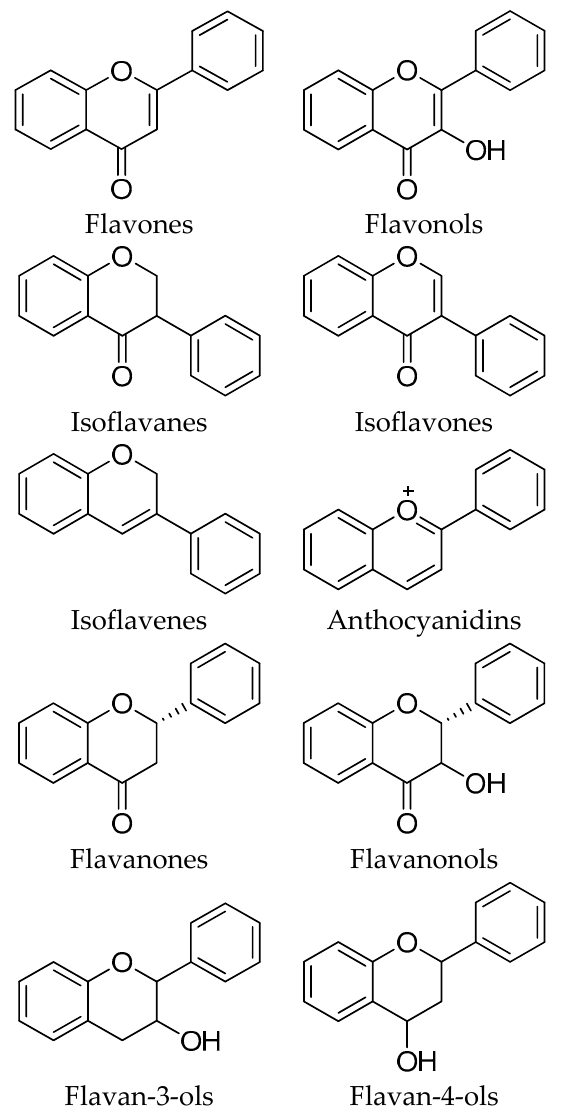
Figure 2. General structures of flavonoid subfamilies.